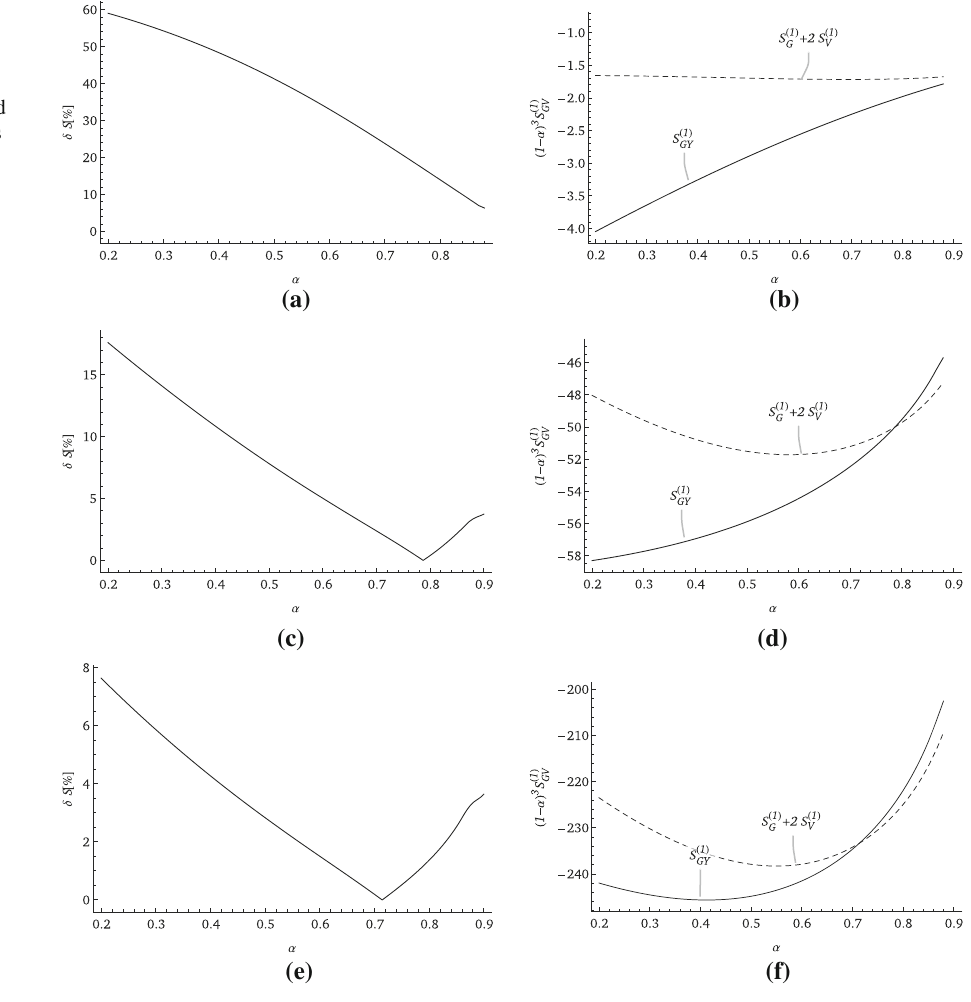
Fig. 4 Comparison of the full Goldstone–Vector determinant with the pure Goldstone and Vector contributions. The Gelfand–Yaglom method is used for all determinants. The figures assumes that the vector-boson mass is m A = g φ . Figure a , b has g = g 2 λ = 1; Fig. a shows δ S ≡